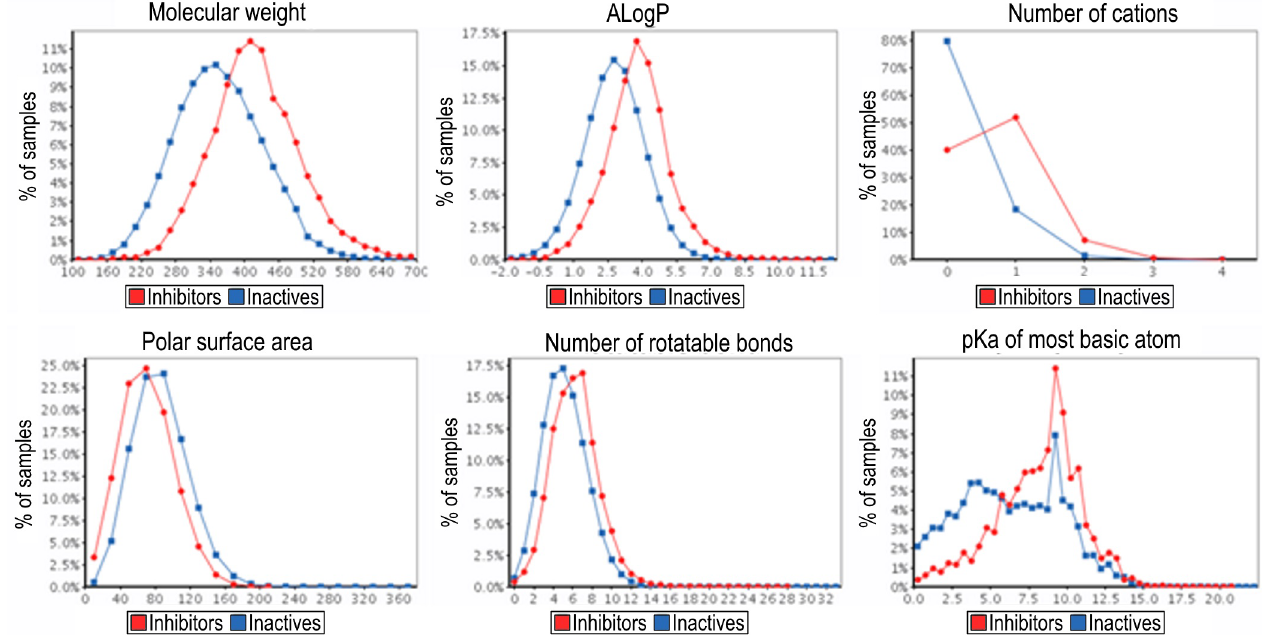
Fig 10. Distribution of 6 physicochemical properties showing significant differences. The distributions of hERG inhibitors and inactive compounds are shown as red and blue lines, respectively.